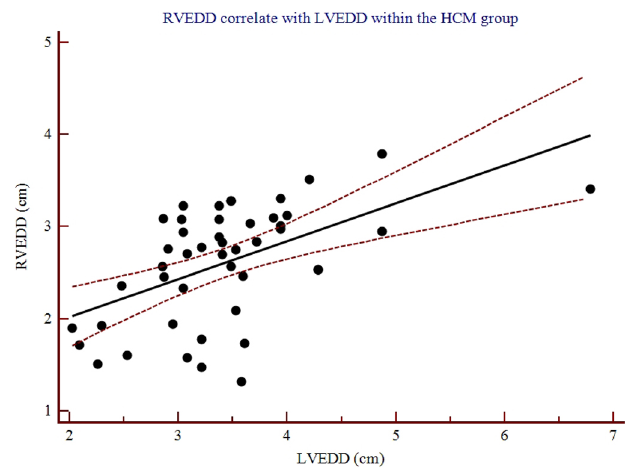
Figure 3. Scatterplots show the close relationship between RVEDD and LVEDD measuring with cardiac MRI (r=0.53, 95% CI: 0.39, 0.71; p ,